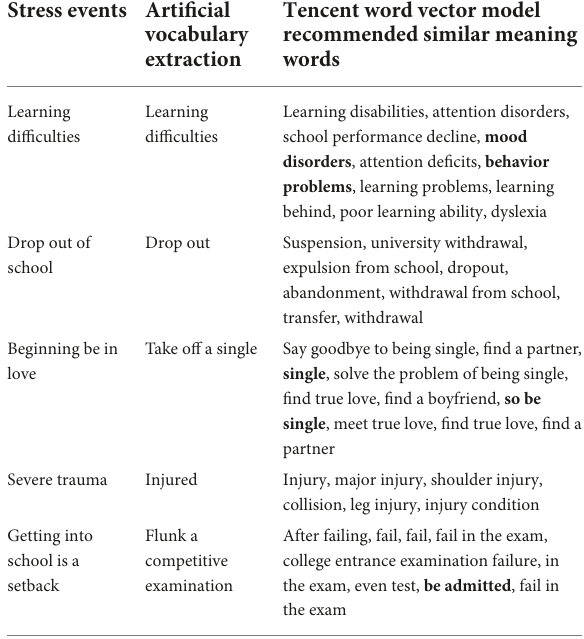
TABLE 1 Word vector model recognition (section).